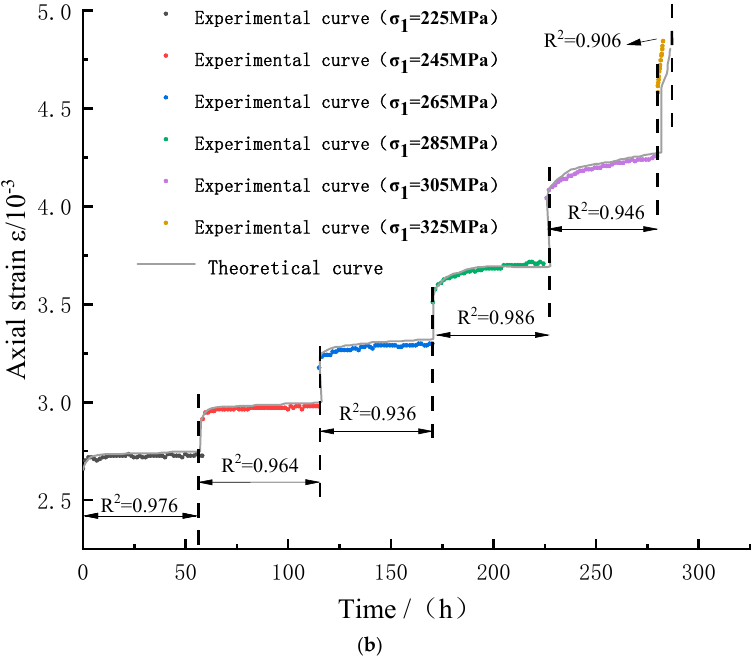
Figure 5. Comparison between experimental and model curves of marble under true triaxial stress. ( a ) σ 3 = 5MPa, σ 1 – σ 3 =220 MPa; ( b ) σ 3 = 5 MPa, σ 2 = 80 MPa.